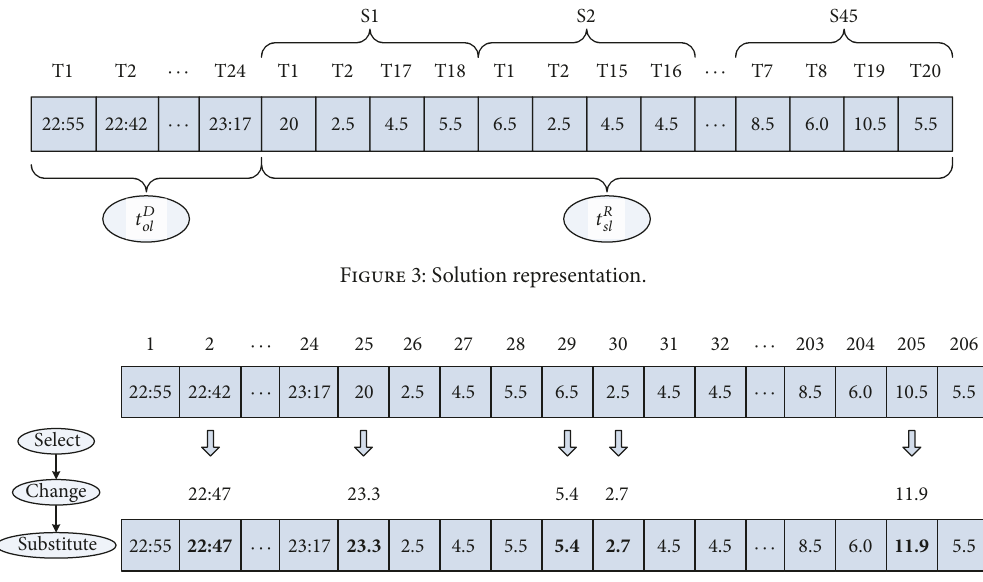
Figure 4: Neighborhood